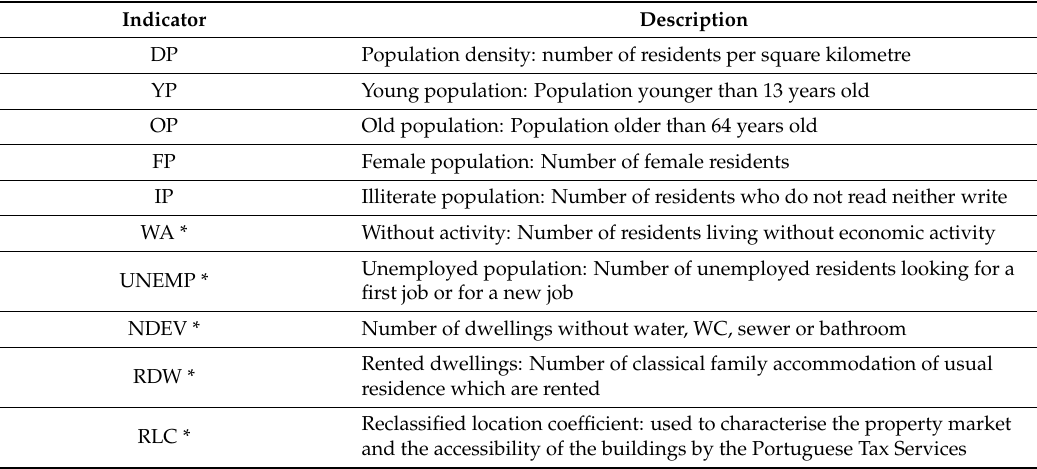
Table 2. Social vulnerability indicators (adapted from